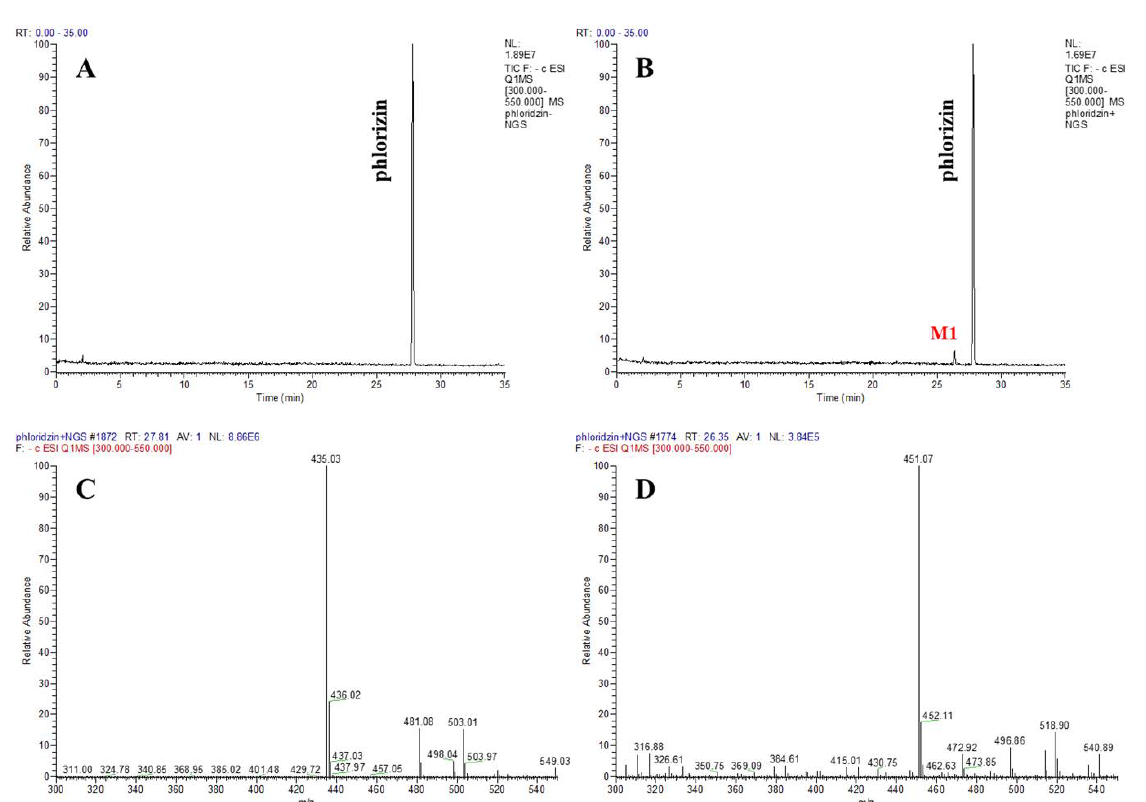
Figure 4. LC–MS analysis of phlorizin and its products produced by CYP102A1 M371 mutant. TIC of phlorizin without NADPH ( A ) and with NADPH ( B ). The MS spectra show that the protonated molecular ions ([M-H] − ) of phlorizin ( C ) and of its major product (M1) ( D ) were 435 and 451, respectively.